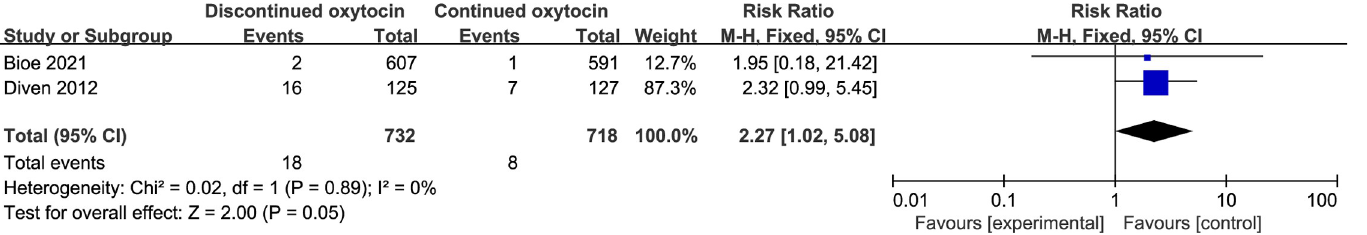
Fig 9. Pooled results for each outcome.